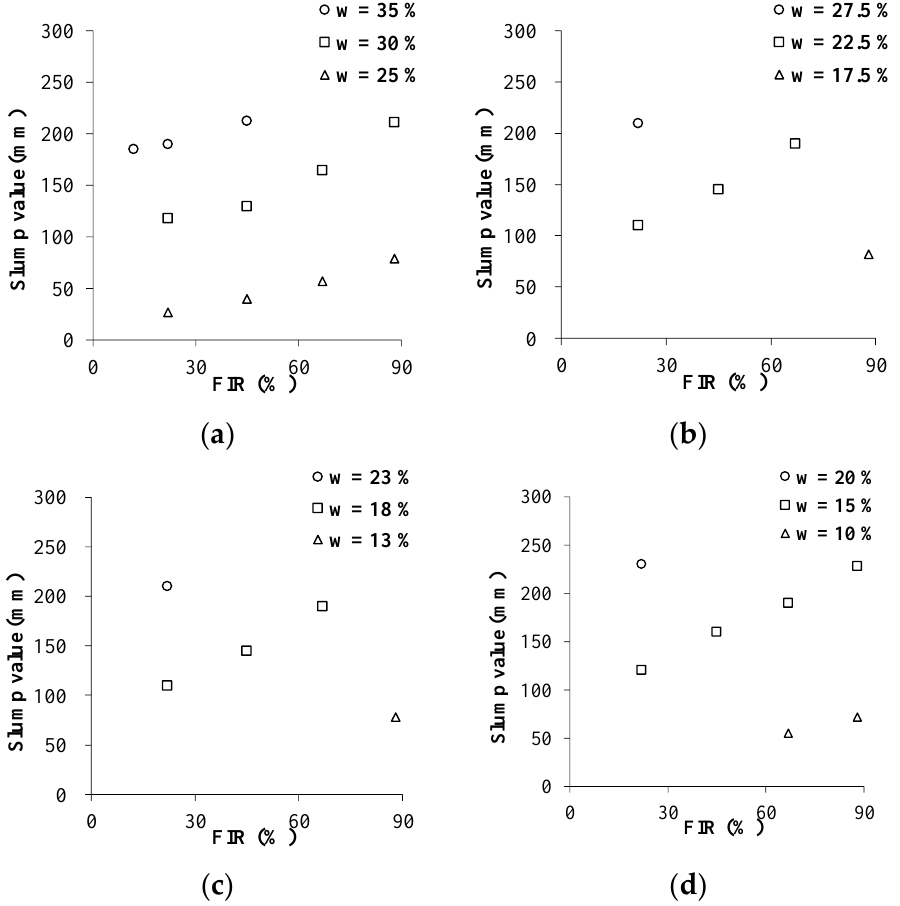
Figure 3. Slump values with variation in the water content and foam injection ratio (FIR) [10]: ( a ) Soil 1, ( b ) Soil 2, ( c ) Soil 3, ( d ) Soil 4.